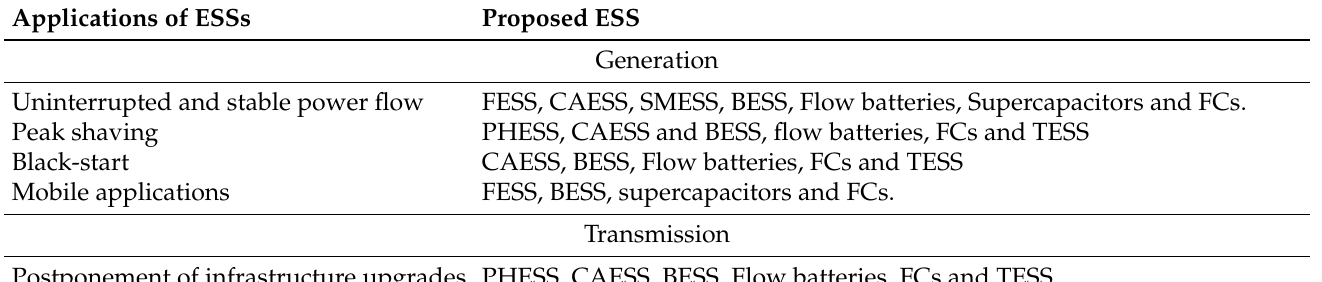
Table 4. Proposed ESSs for various